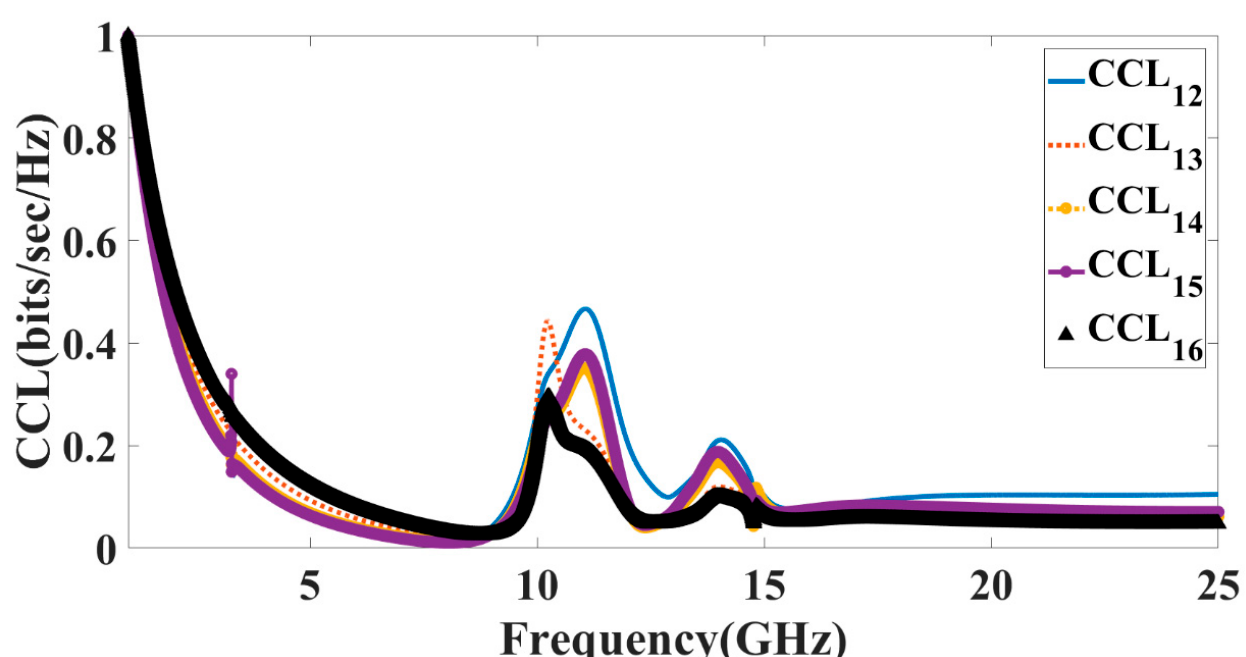
Figure 16. Calculated values of the CCL for antenna Design 5.